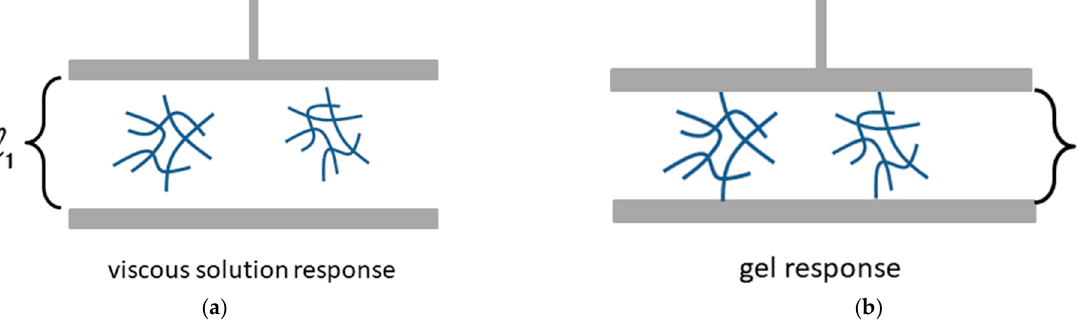
Figure 17. Schematic representation of a plate-plate set-up in a rheometer: ( a ) aggregates of size smaller than l 1 giving a viscous response. ( b ) aggregates of size larger than l 2 giving a gel response [50].